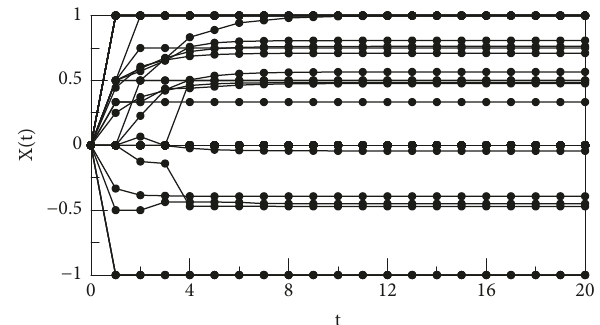
Figure 6: Convergence of the node opinions inferred through iterative process corresponding to the opinion formation model for onehundrednodesrandomly.Notethatmanynodesfollowthesame